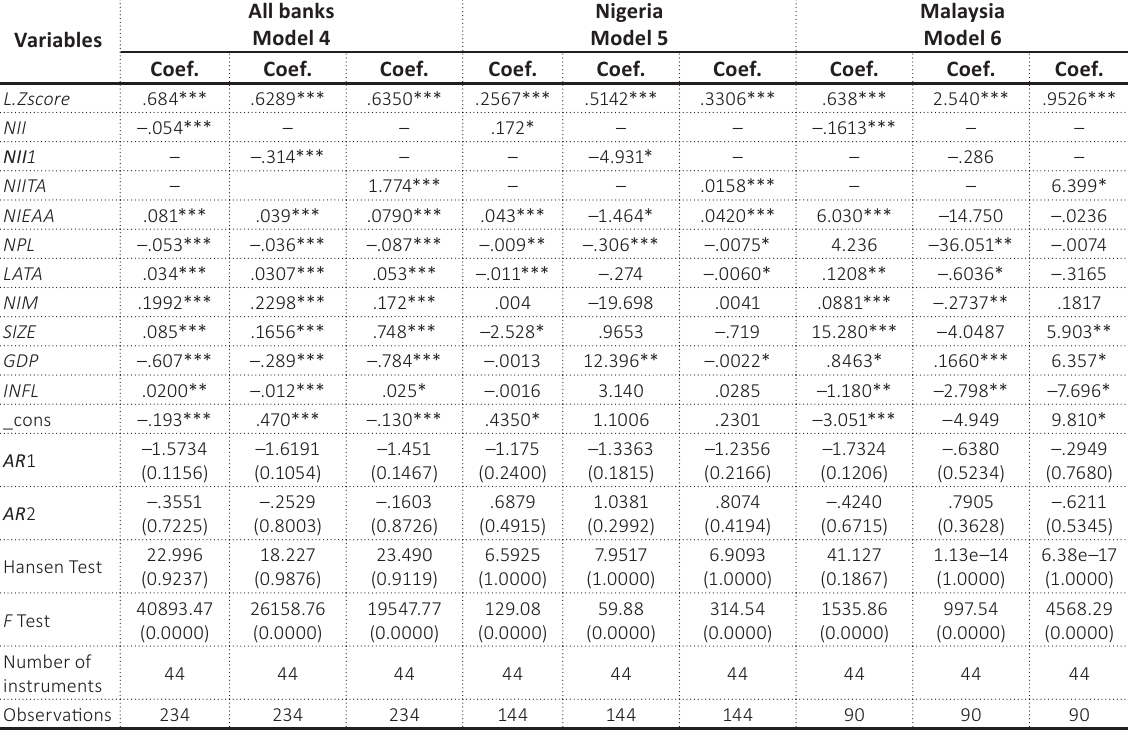
Table 3. Bank stability (Z-score) sys-GMM model